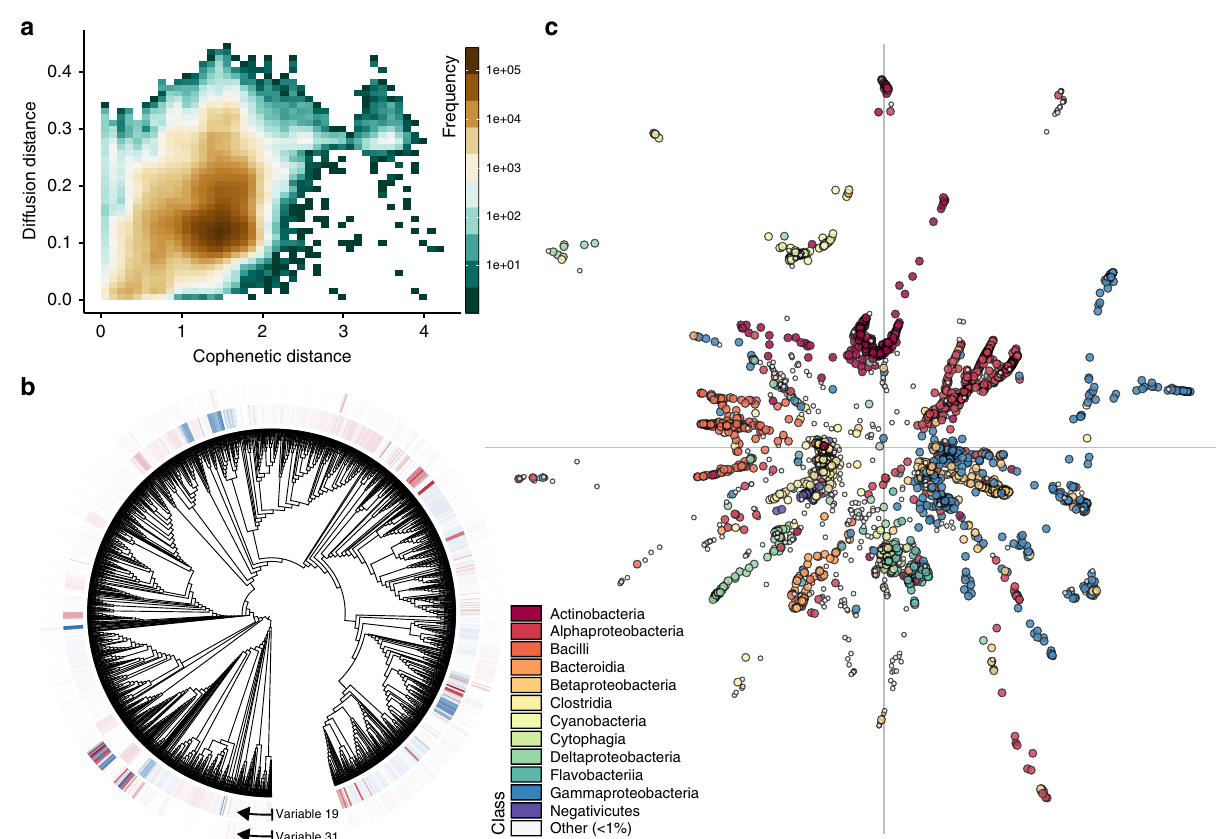
Fig. 3 Metabolic and phylogenetic similarities are roughly correlated. a The correlation between distances in diffusion space and cophenetic distances between genome pairs (Mantel test, r = 0.273, P < 0.001). b Some variables such as 19 show similar functional capabilities shared by remotely related taxa (similar colors in distal parts of the tree). Others such as variable 31 highlight differences in closely related taxa, corresponding to the appearance of large positive and negative values (dark blue and red shades) in close proximity on the tree. c A 2-dimensional embedding of diffusion variables 36 , where individual genomes (points) are colored by taxonomic class. Axes mark (0, 0) in the coordinate system.